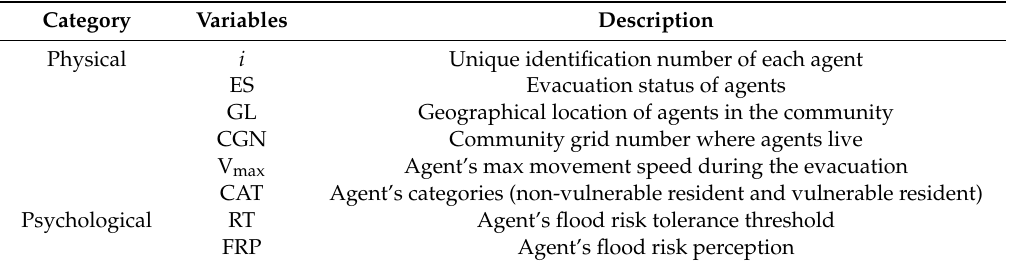
Table 1. List of resident agents’ attributes.